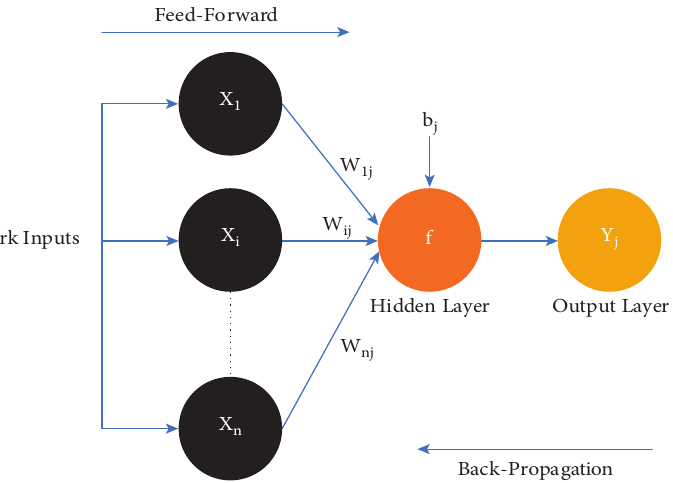
Figure 3: Schematic diagram of MLP for node j